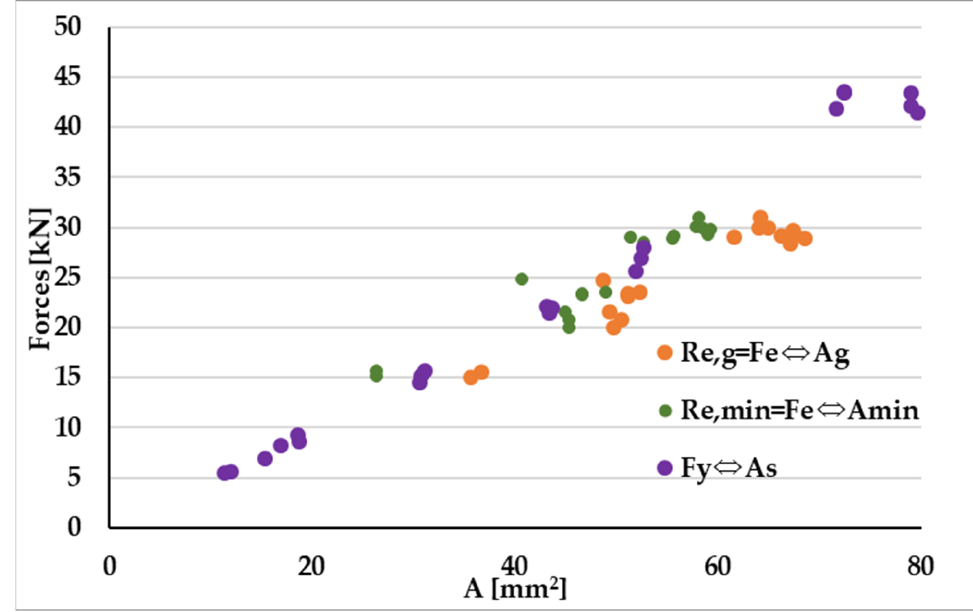
Figure 16. Dependence of the force on the yield strength F e related to the relevant area of the cross-section φ 10 (to minimum area A min and to the area determined from the weight loss A g ).